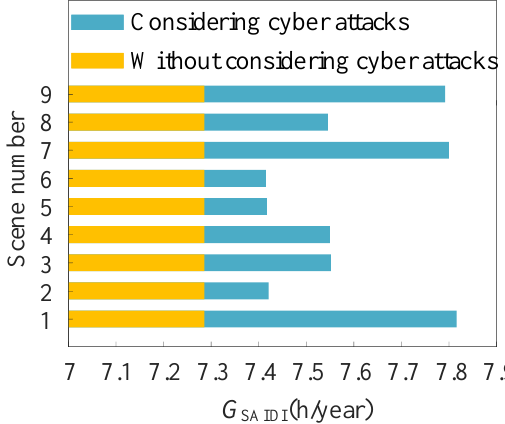
Figure 18. Impact of attacking two IEDs on G SAIDI .